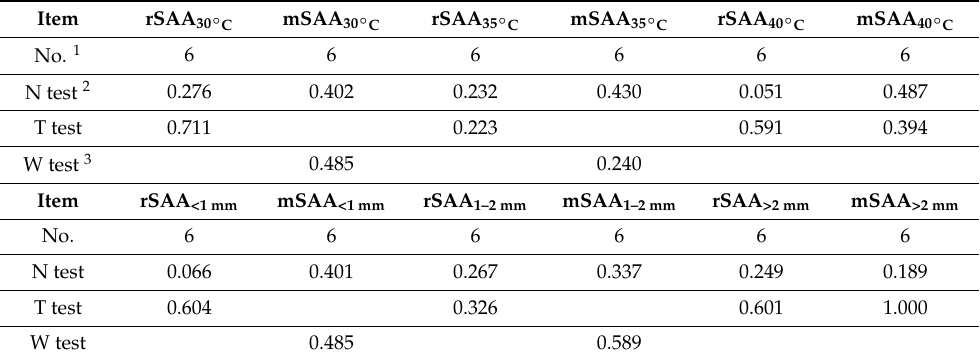
Table 2. P -values resulting from the Shapiro–Wilk normality, t -test, and Wilcoxon rank-sum test for rSAA and mSAA.